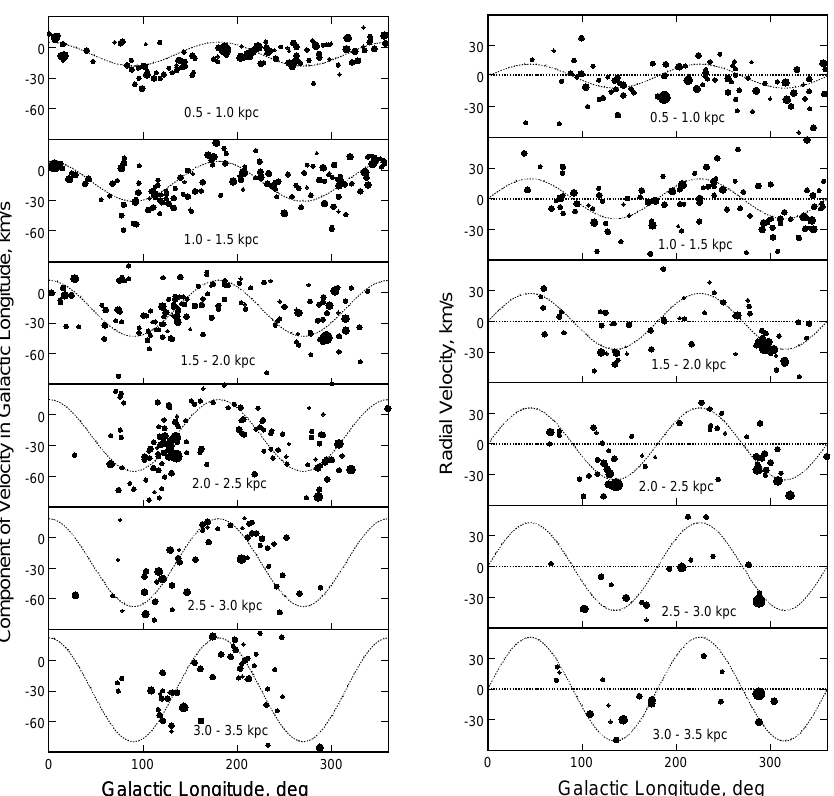
Fig. 1. The components of the velocity in galactic longitude (left) and radial velocities (right) corrected for the solar motion as functions galactic longitude for different intervals of heliocentric